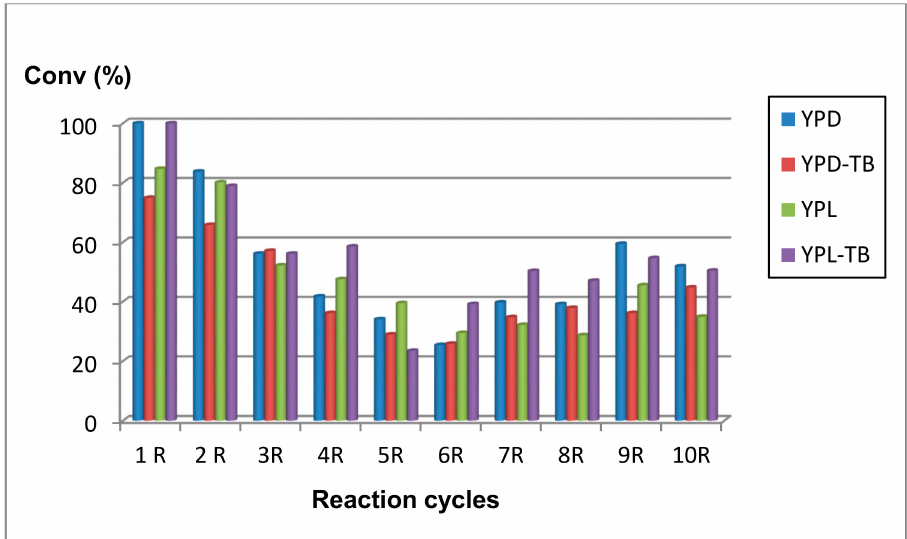
Figure 3. Yield of the selective transesterification reaction in successive reuses of the same biocatalytic system, under standard reaction conditions: 6 mL of sunflower oil, 1.75 mL of ethanol, 30 ◦ C, 25 µ L of 10 N NaOH solution, stirring higher than 300 rpm, during 6 h as reaction time. As a biocatalyst is applied 0.5 g of enzymatic extract from a standard CA strain purchased in the CECT, obtained from several growths